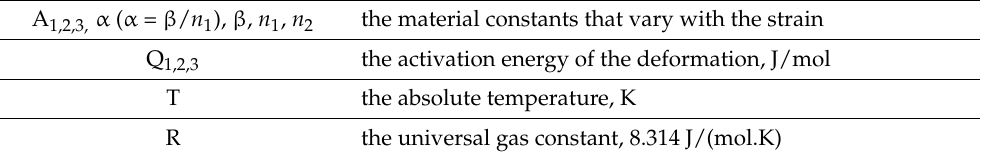
Table 1. The equations constants.